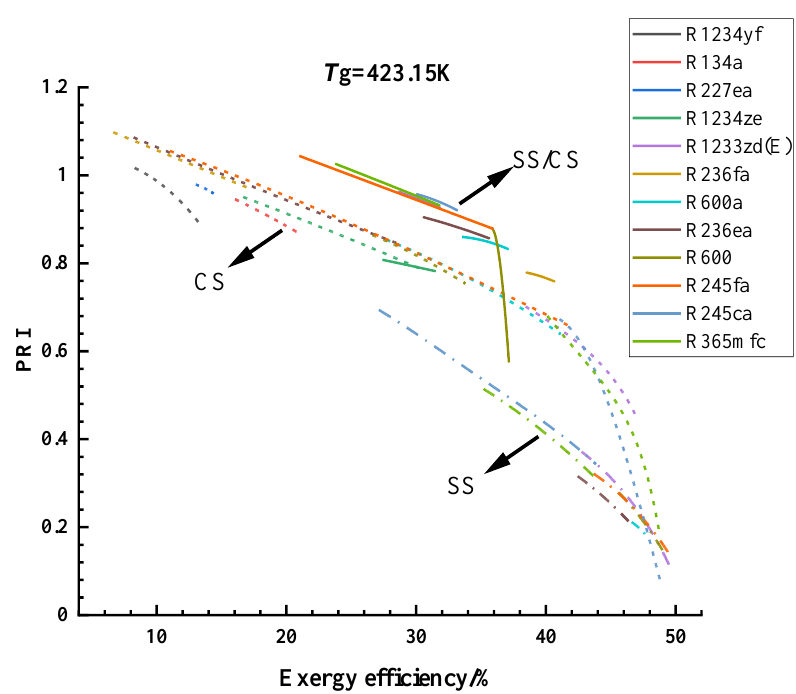
Figure 8. Optimized results under the heat source temperature of 423.15 K.